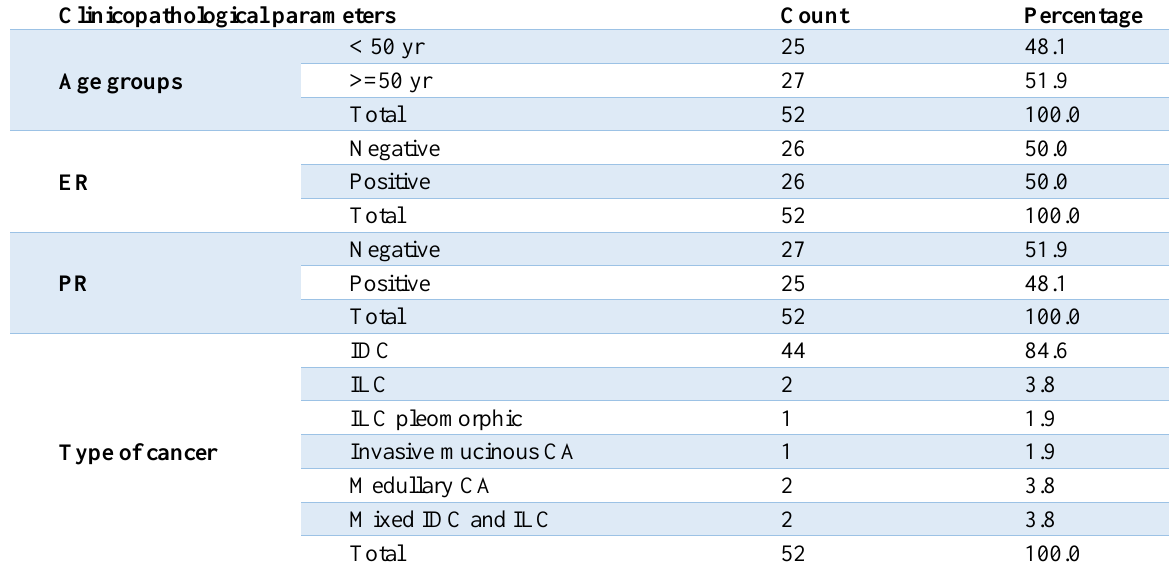
Fig. 4. Invasive Ductal Carcinoma of Breast with Positive Brown Nuclear Staining (arrows) of Estrogen Receptor (ER) Immunohistochemistry of Score 8/8 According to Allred Scoring Method (20X). Table. 2. Descriptive Analysis of the Clinicopathological Parameters of the Studied Cases